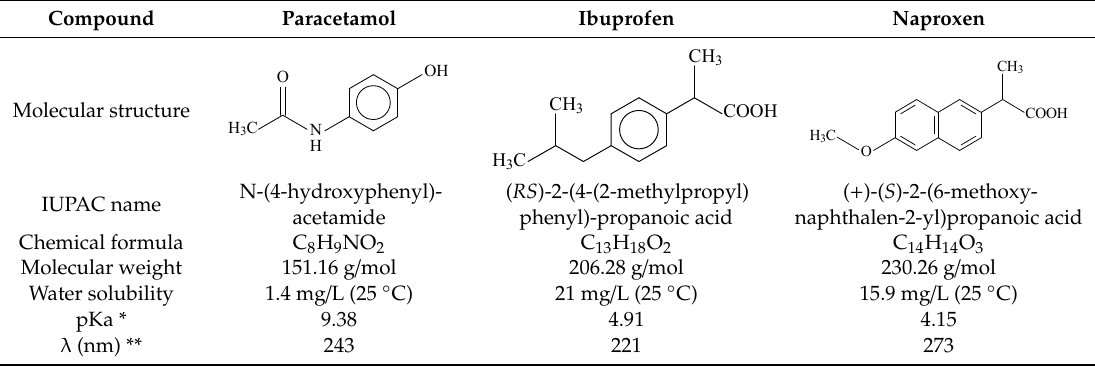
Table 1. Chemical structures and selected properties of the adsorbates [33].